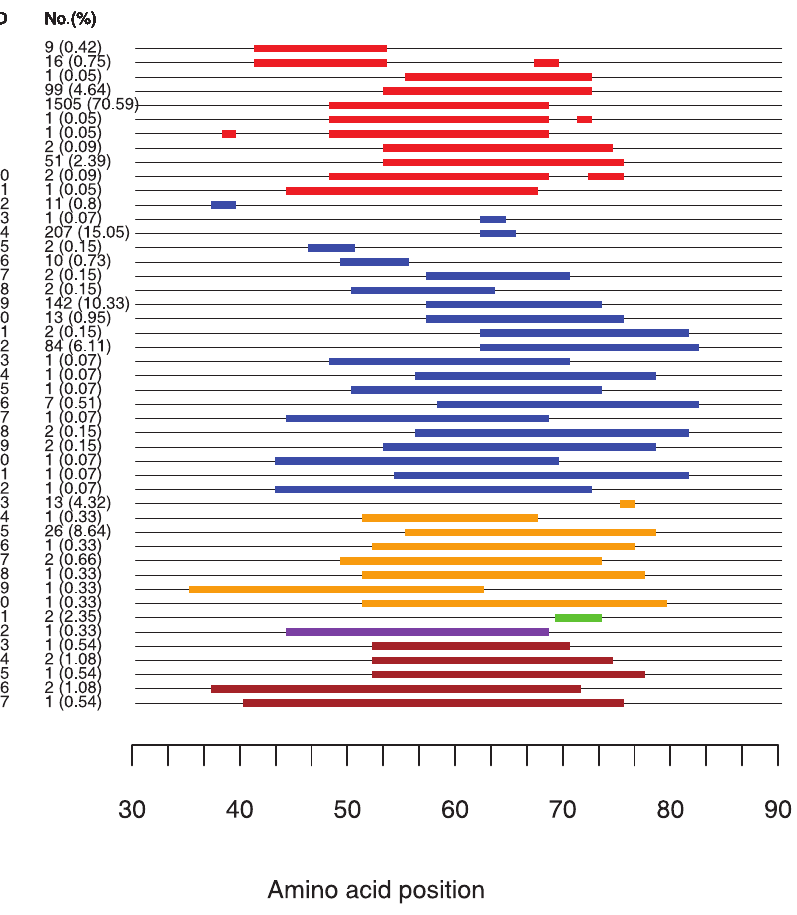
Figure 1. Patterns and prevalence of AIV S D NA. Bars represent positions of missing amino acid residues. Colors indicate NA subtypes (red = N1, blue = N2, orange = N3, green = N5, purple = N6 and brown = N7). The first column on the left shows the deletion IDs assigned to each pattern. The second column shows the number of sequences having the corresponding deletion pattern and in parentheses the percentage of this pattern among all sequences of the same NA subtype. Percentages do not sum to 100 for the entire graph since they are calculated per NA subtype. Table S1). Pattern 22 persisted for 25 years and appeared in both Asian and North American isolates (Figure 3 and S3).